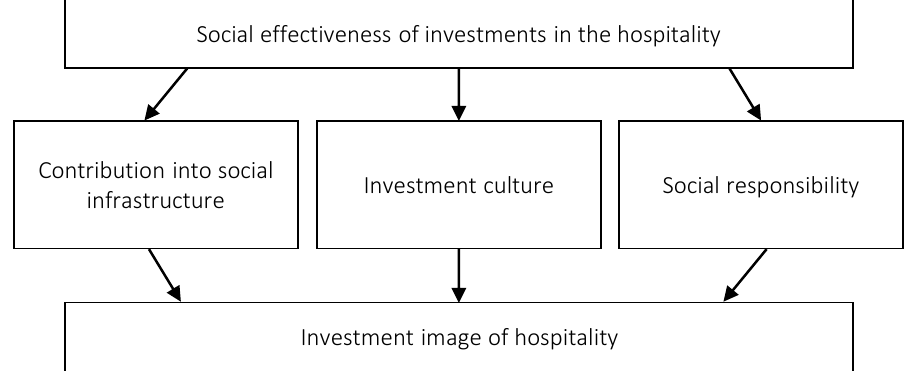
Figure 2. Decomposition of hospitality social